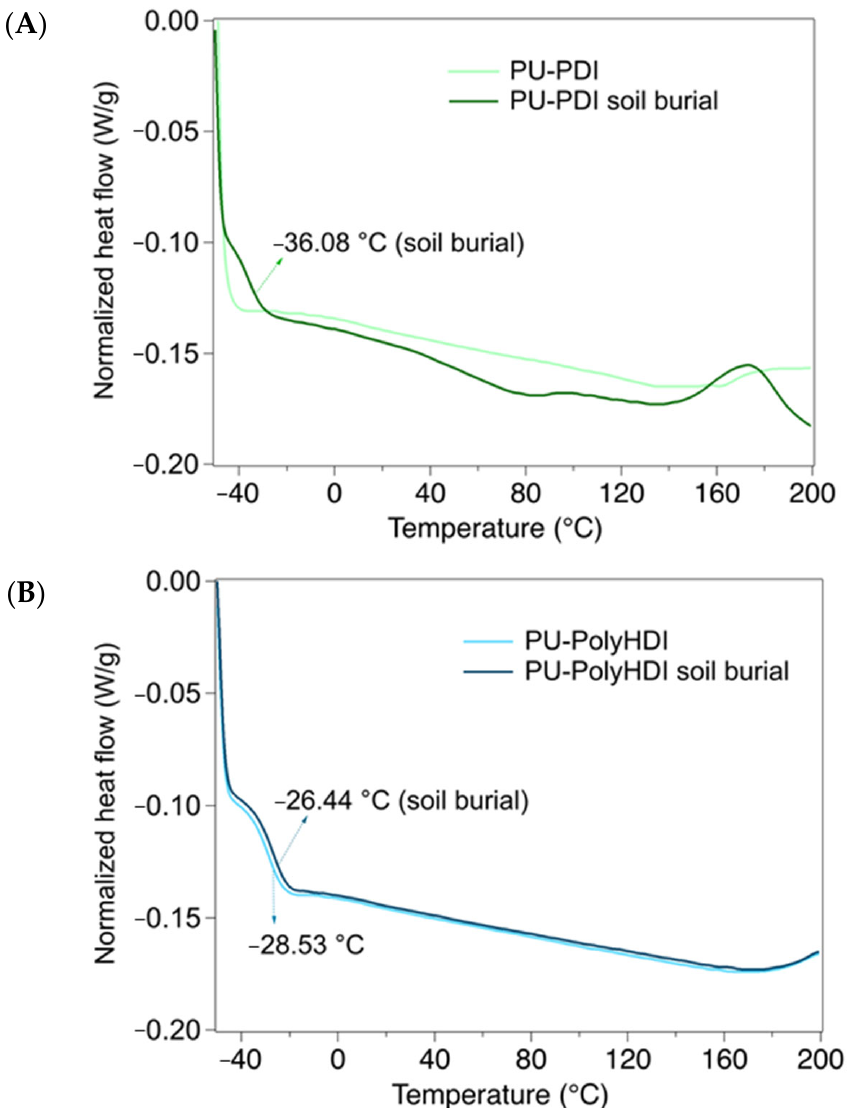
Figure 8. DSC profiles of PU samples before and after 150 days of soil burial test. ( A ) PU ‐ PDI, and ( B ) PU ‐ PolyHDI.